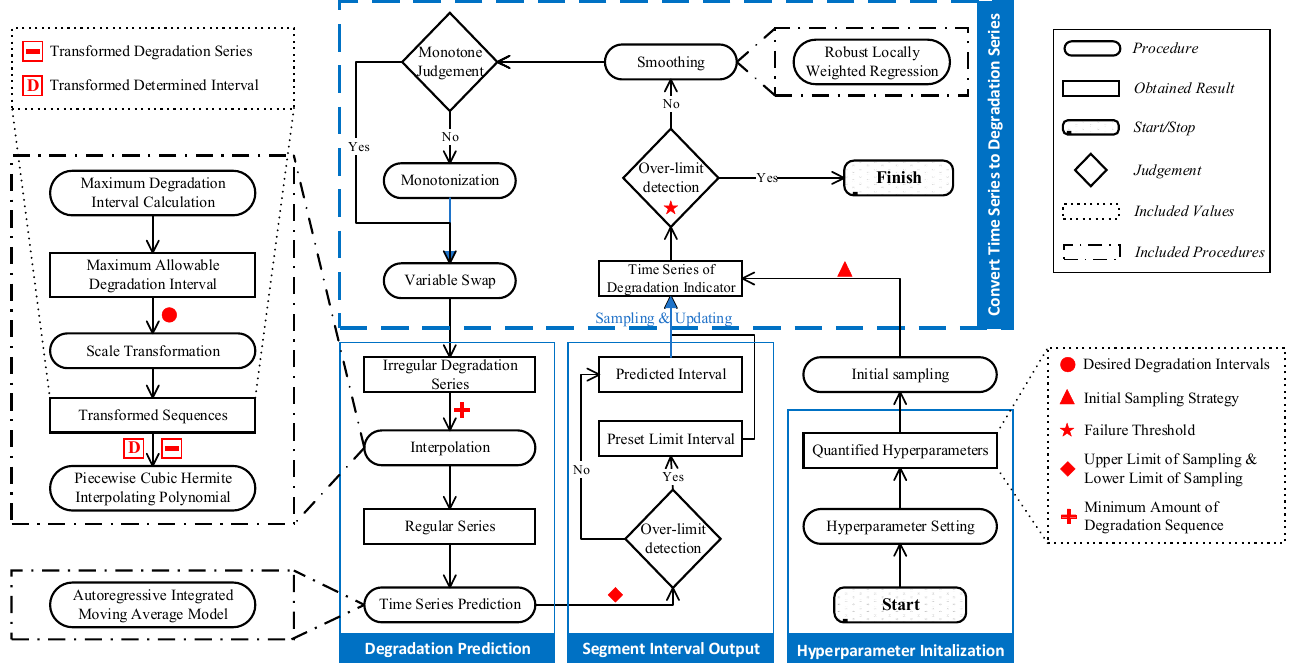
Figure 6. Flow chart of IIS method for mechanical degradation